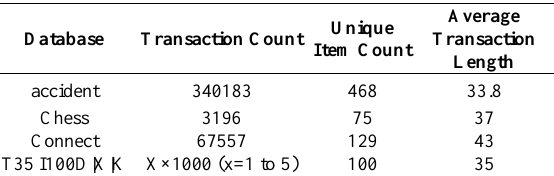
Table 6. Parameter of the